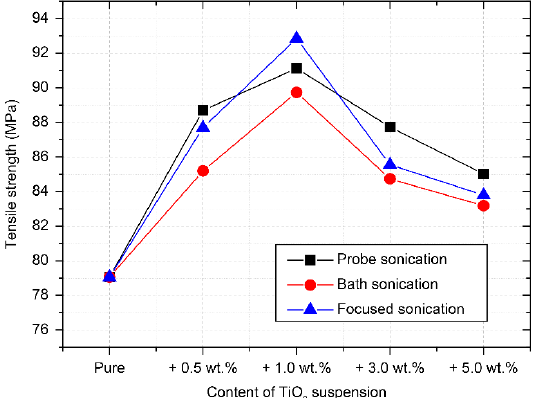
Figure 6. Tensile strength of the TiO 2 –epoxy nanocomposites in accordance with the sonication method.